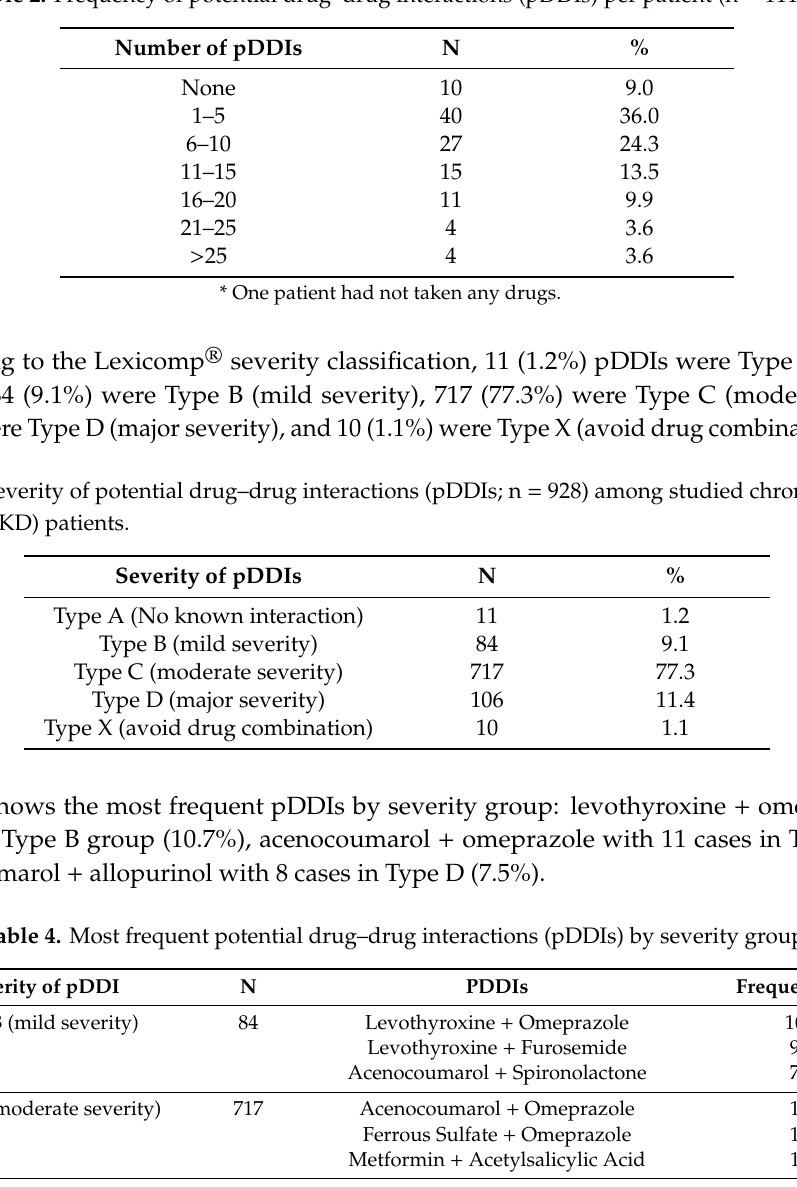
Table 2. Frequency of potential drug–drug interactions (pDDIs) per patient (n = 111 *).